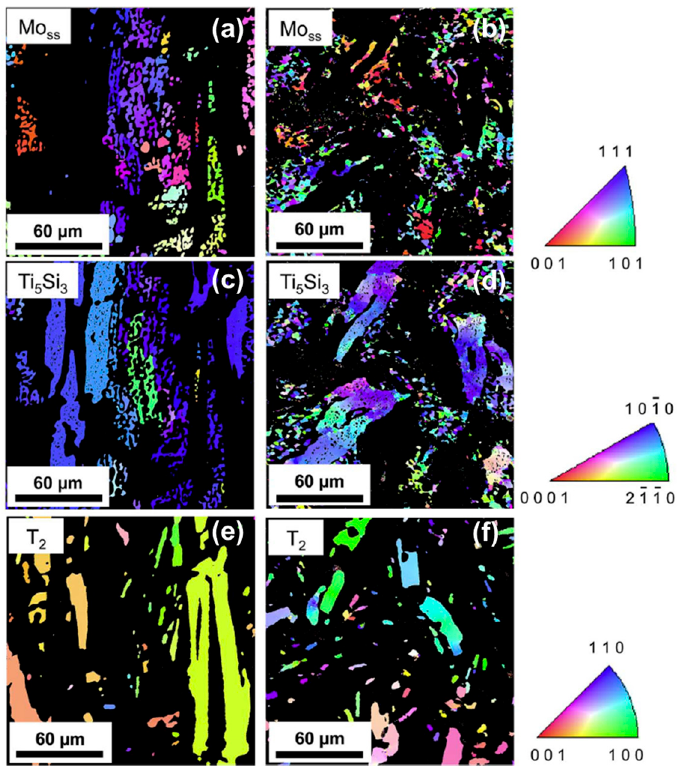
Figure 11. IPF maps of the main constitution phases ( a , c , e ) before and ( b , d , f ) after high-temperature deformation [35].